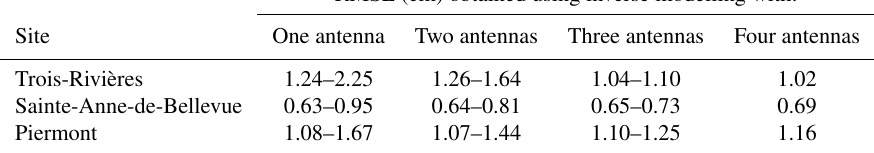
Table 2. Summary of results obtained using different combinations of antennas to retrieve water level measurements. For one to three antennas, the RMSE for every combination of antennas at each site was calculated, but only the lowest and highest values are shown in the table. RMSE (cm) obtained using inverse modelling with: Site One antenna Two antennas Three antennas Four antennas Trois-Rivières